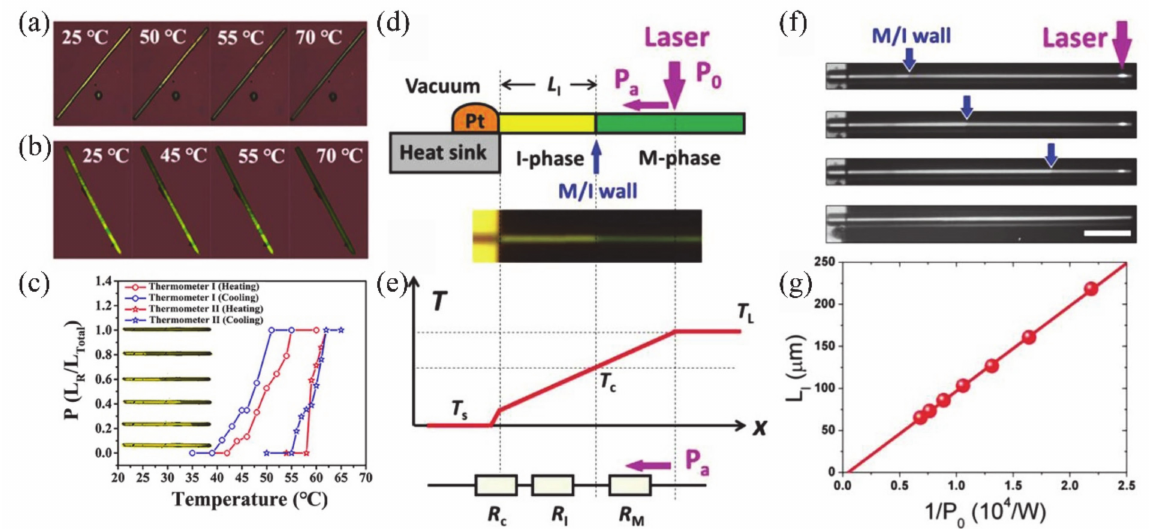
Figure 26. ( a , b ) Optical images of VO 2 NWs during the heating process. ( c ) Plots of domain wall position along the graded-doping VO 2 (M) NWs under the different temperatures and the corresponding optical images of an annealed thermometer with the increasing temperature. Reproduced from [181], with permission from American Chemical Society, 2017. ( d ) Schematic of the working principle about a near-field power meter based on the cantilevered VO 2 beam, and the optical image shows the position of the domain wall along the beam. ( e ) Schematic of temperature profile along the VO 2 microbeam. ( f ) Optical images of the domain wall movement under increasing (bottom to top) laser power. ( g ) Plot of the length of the insulating domain and the reciprocal of incident laser power. Reproduced from [182], with permission from John Wiley and Sons,